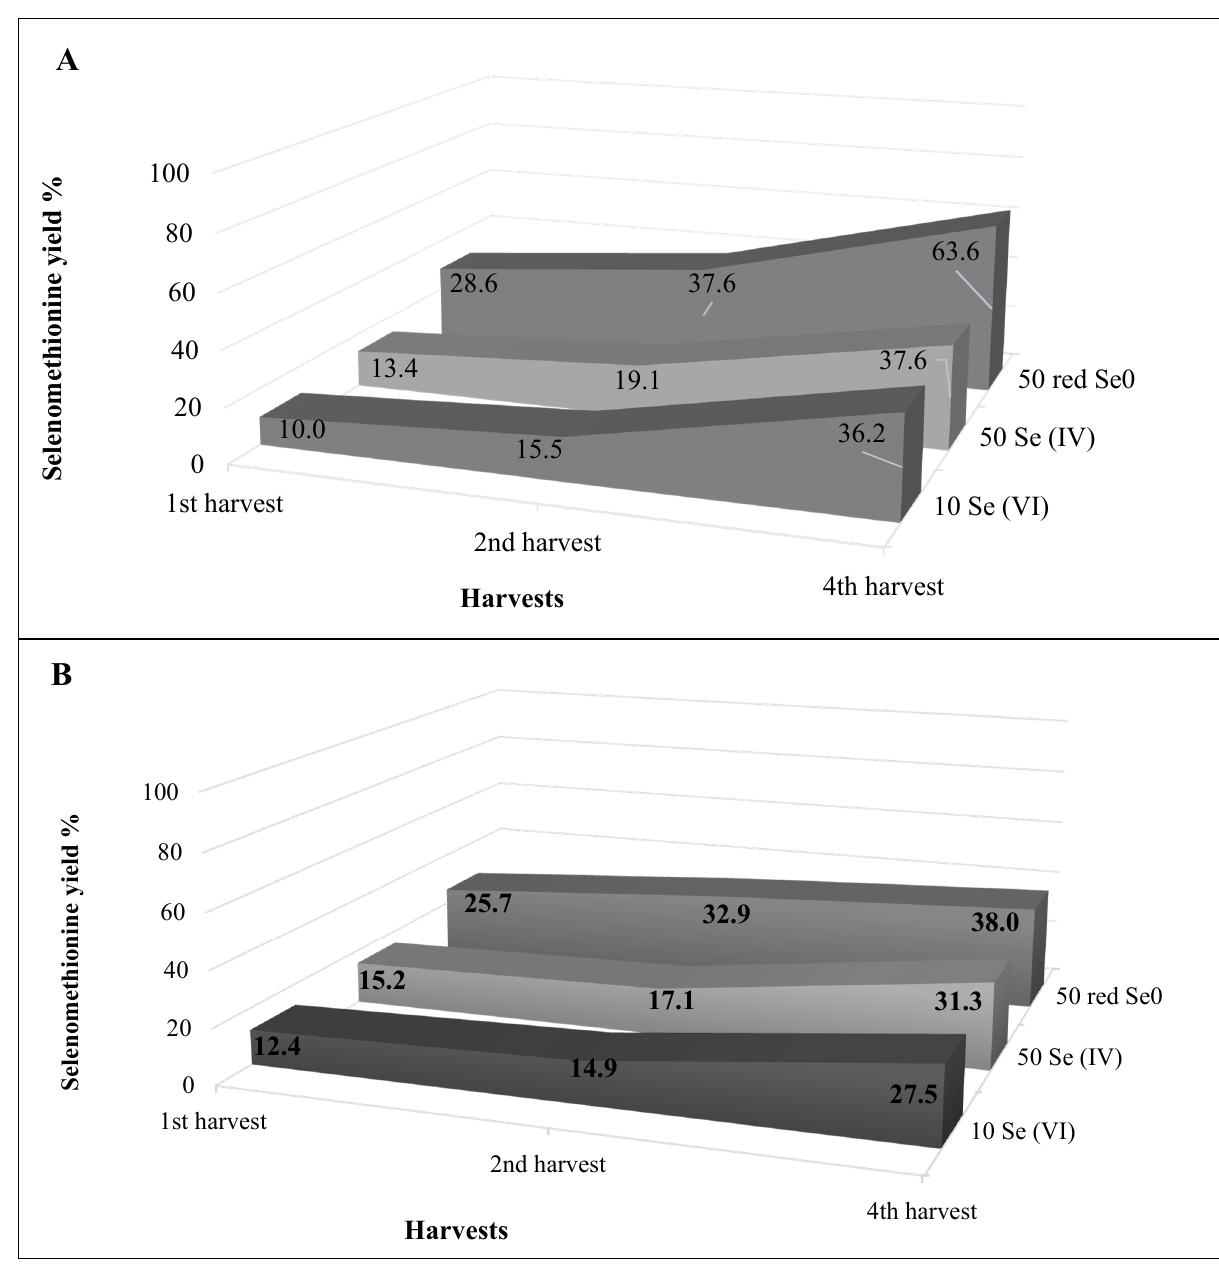
Figure 2. Selenomethionine (SeMet) yield % in alfalfa aboveground biomass ( A : stem; B : leaves) fertilized with different Se forms (i.e., Se (VI), Se (IV), and red Se 0 ) at different concentrations (10 and 50 mg kg −1 for ionic form and 50 mg L −1 for red Se 0 ) within three harvests.